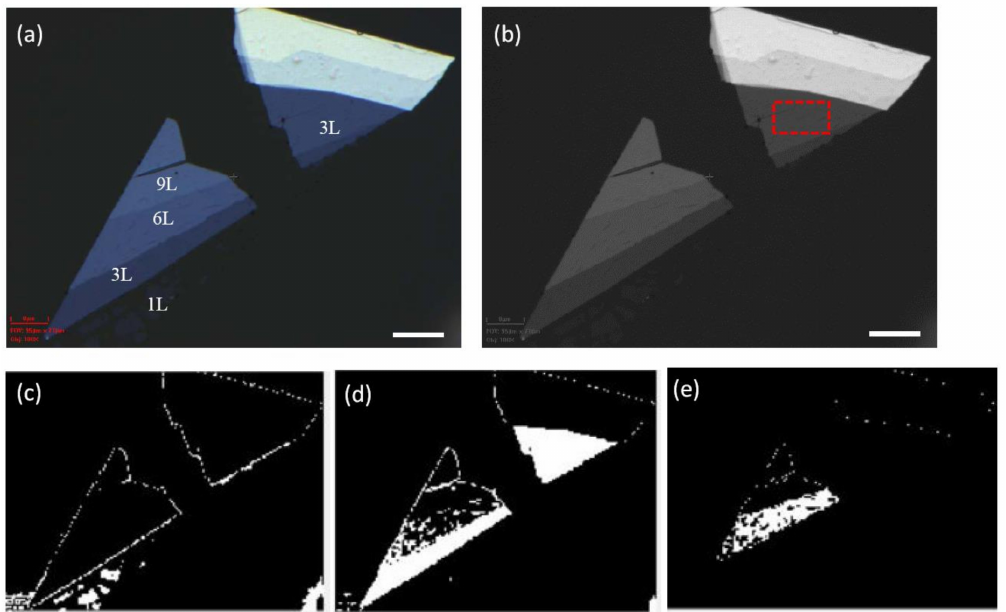
Figure 3. ( a ) Reflective optical microscope image of a MoS 2 flake taken with a 100 × objective. ( b ) Gray scale image after binarization. The red dashed rectangular indicates the selected area for spectral calculation. ( c ) The monolayer areas are highlighted in the image as the white areas by setting the threshold as 15–20. The boundaries of the flakes are also indicated. ( d ) The tri-layer areas are identified in the image as white areas by setting the threshold as 24–28. ( e ) The 6-layer areas are identified in the image as white areas. The white scale bar in the figure is 10 µ